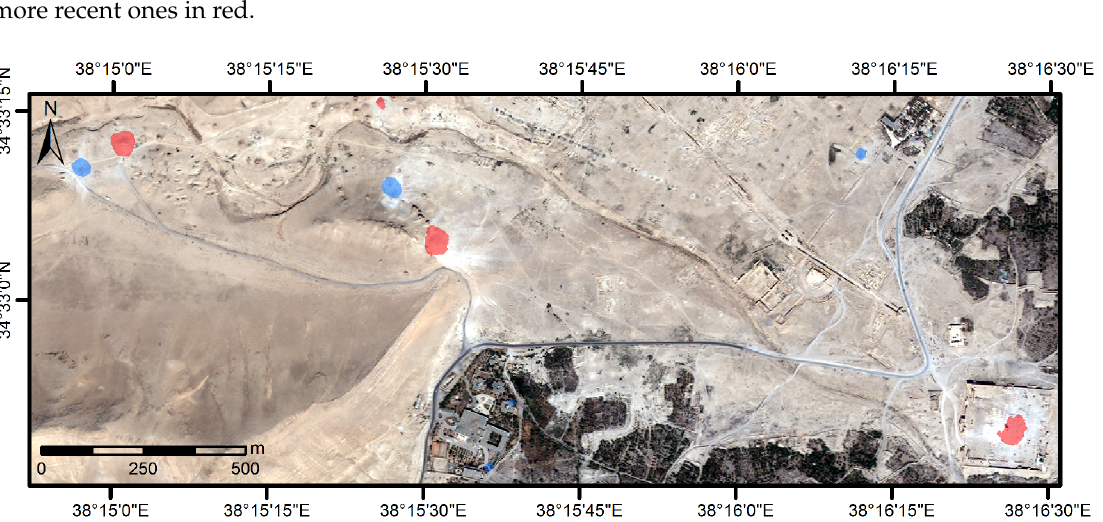
Figure 12. Multitemporal representation of damage overlaid on the 2 September 2015 WorldView-2 image reported in Figure 5 ( c (cid:13) European Space Imaging/DigitalGlobe). Damage that occurred between t 0 and t 1 and between t 1 and t 2 is highlighted in blue and red,